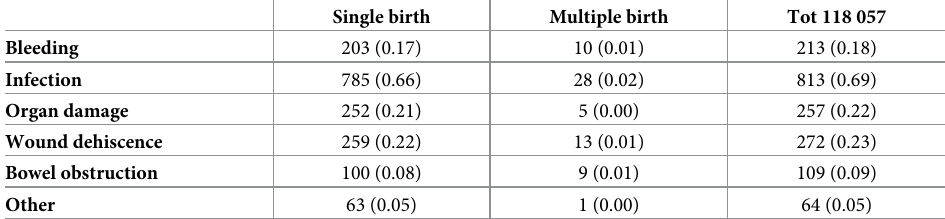
Table 3. Complications within 42 days after caesarean section.